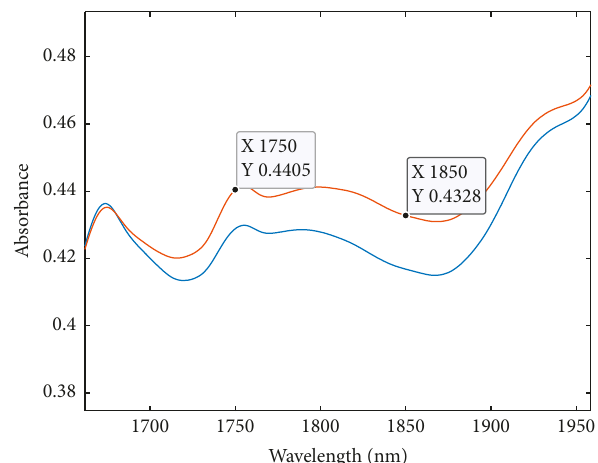
Figure 2: The “VB +VC (1) (1) actual spectrum” of 1750–1850nm. −